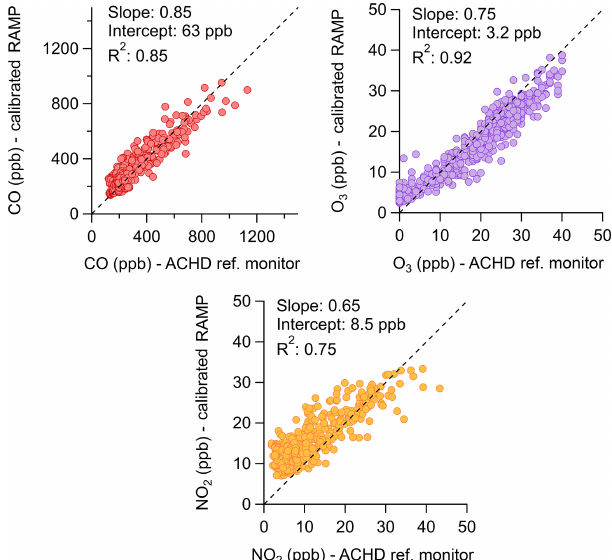
Figure 12. Comparison of CO, NO 2 , and O 3 hourly average concentrations measured by a collocated RAMP monitor and the reference monitors at the Allegheny County Health Department (ACHD). The RAMP monitor was first calibrated on the Carnegie Mellon campus prior to